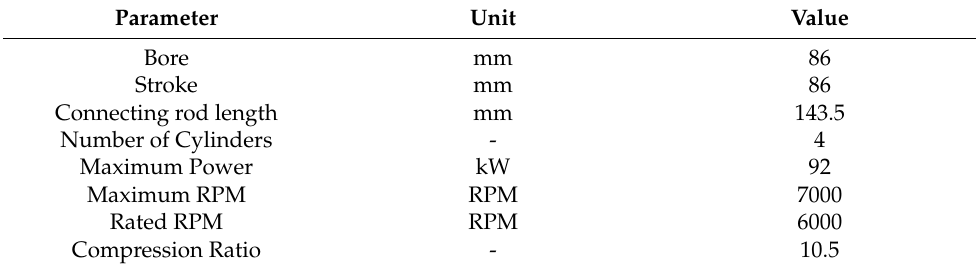
Table 1. KIA Cerato engine